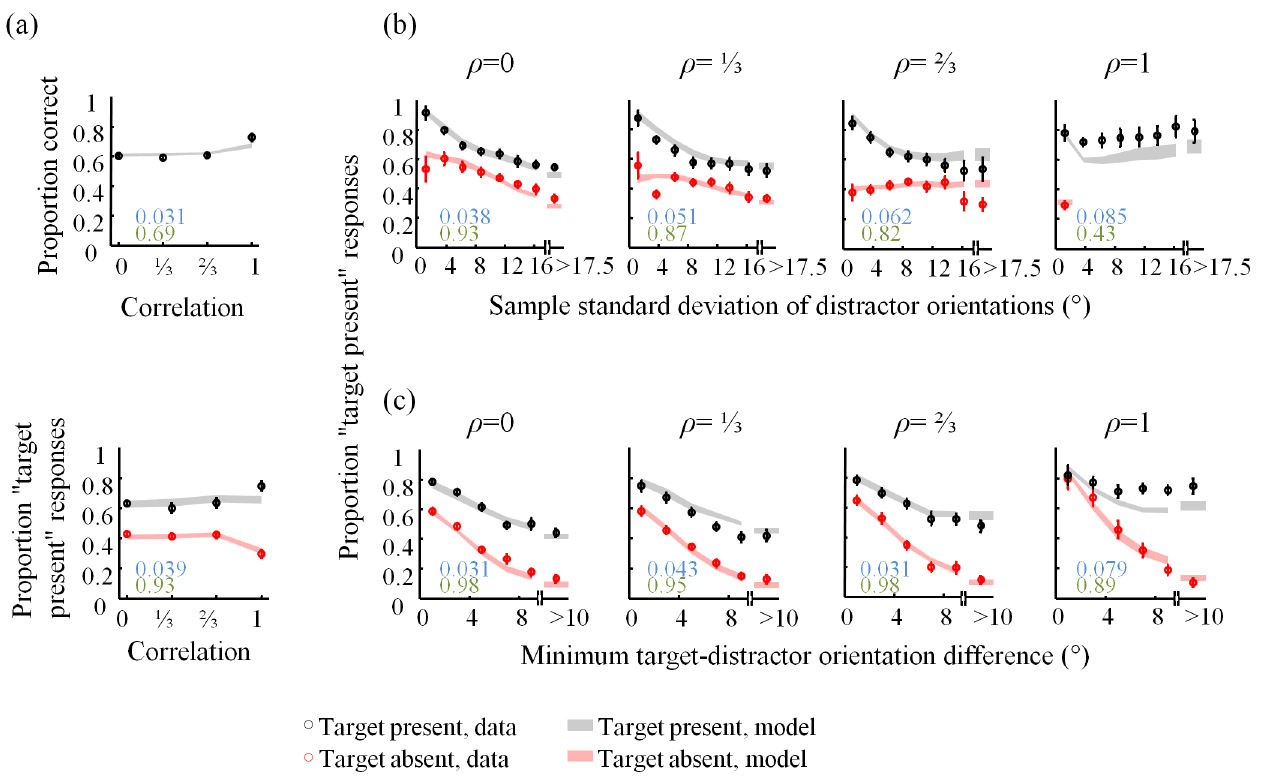
Fig 8. Fits of the VP1 model to the summary statistics. For caption, see Fig